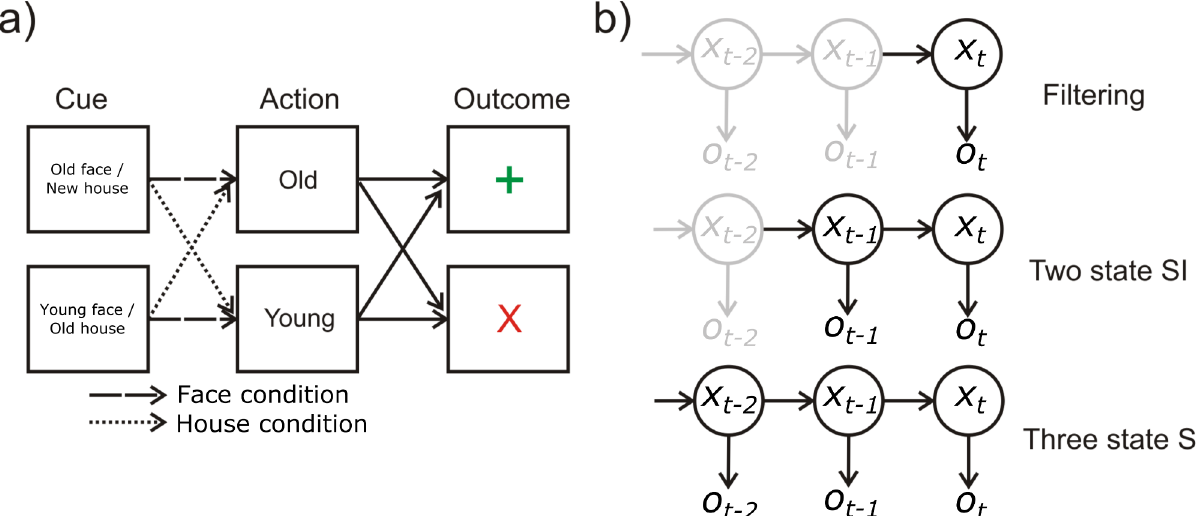
Fig 1. (a) Probabilisticreversaltask. On each trial, subjects were presentedwith one of two compoundstimuli. These consisted of overlaid images of either an old face and younghouse (top) or young face and old house (bottom). Subjects were instructed to respond‘old’ or ‘young’ depending on whether they were in the face or house condition, and that this conditionwould switch periodically.They were then given feedbackbasedon their choices, with a reliabilityof 0.85 (in other words, correct decisionsresulted in positive feedbackon 85% of occasions) (b) Cartoonillustratingsequential inference. An agent implementing pure filtering performs inferences about the current state ( x t ) basedon fixed beliefs about the precedingstate ( x t-1 ), together with a current observation ( o t ). In n step sequential inference,the agent simultaneously optimisesbeliefs about both current and past states (up to a depth n ). This correspondsto performinginferenceover a sequenceof n+1 states, rather than only performinginference over the current state. Under conditions where states are only partially observable (where there is no one-to-onemappingbetweenstates and observations), and where there are significantcausal dependencies betweenstates, this has the potentialto significantly improvemodel performance.